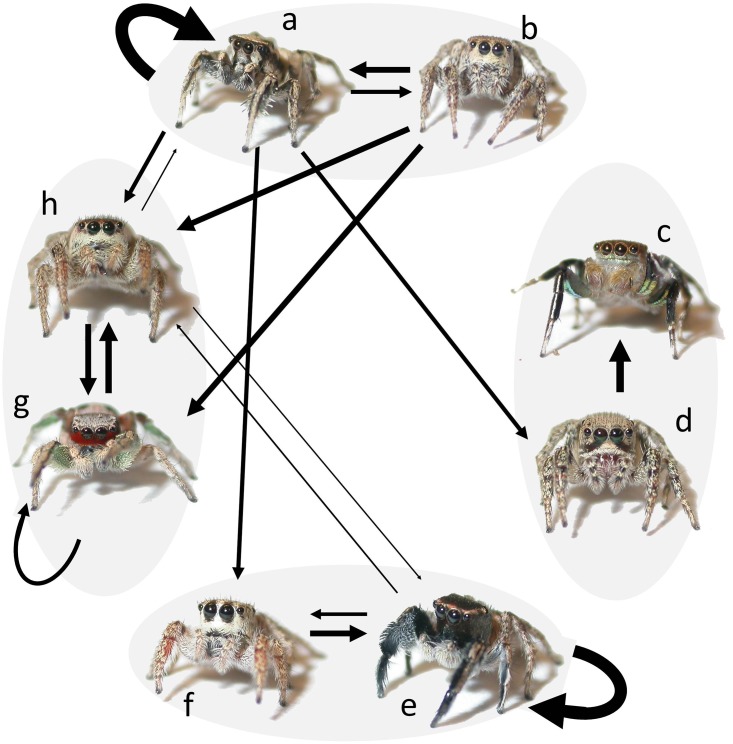
Summary of interactions between sexually mature adults in four species of sympatric Habronattus illustrating how rates of misdirected courtship likely vary by species.Thickness of arrows represents the relative frequency of interactions per observation (with wider arrows indicating more frequent interactions). Curved arrows indicate interactions between individuals of the same species and sex. In 100% of interactions between adult males and adult females (regardless of species), courtship occurred. H. clypeatus male (a) and female (b), H. hallani male (c) and female (d), H. hirsutus male (e) and female (f), and H. pyrrithrix male (g) and female (h).